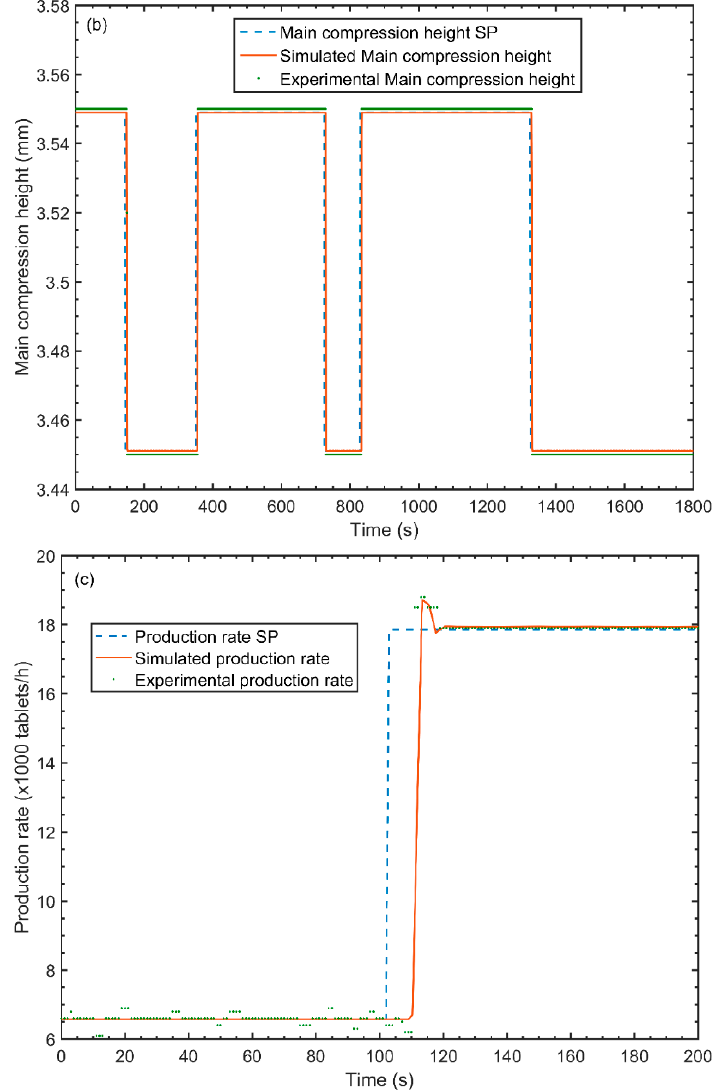
Figure 5. ( a ) Fill depth model validation ( b ) Main compression height model validation ( c ) Production rate model validation (SP: set point). Table 1. Model parameters—Actuators. Table 1. Model